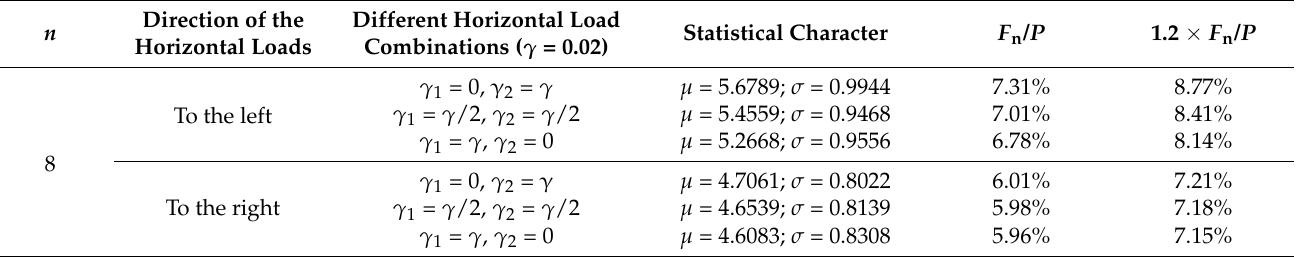
Table 4. Statistical results of ( F / P ) × 100 and F n / P * under different horizontal load combinations.